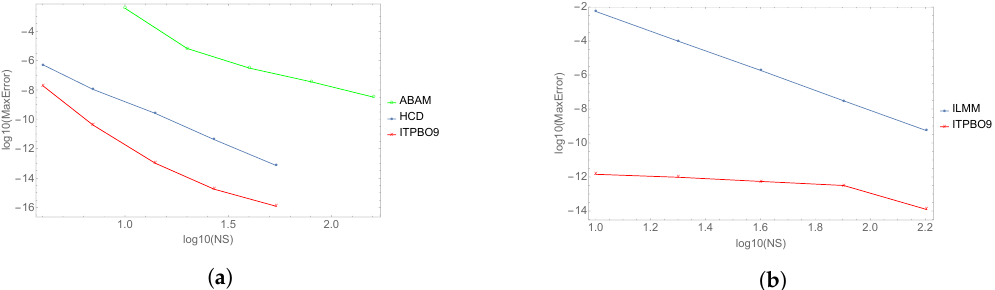
Figure 1. Efficiency curves of log maximum absolute error versus number of steps, NS. ( a ) Problem 1, ( b ) Problem